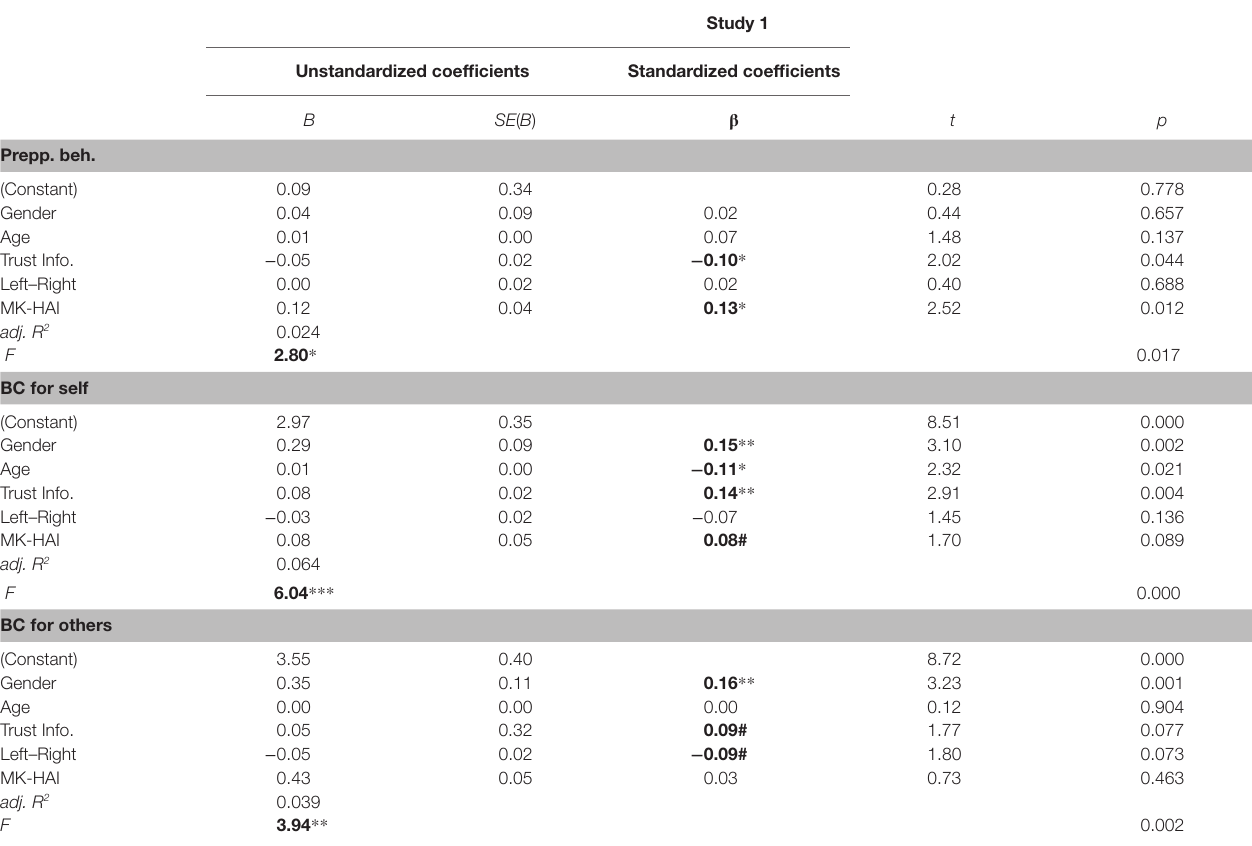
TABLE 3 | Multiple linear regressions on self-centered prepping behavior, behavior change to avoid infection, and behavior change in order to not infect others in Study